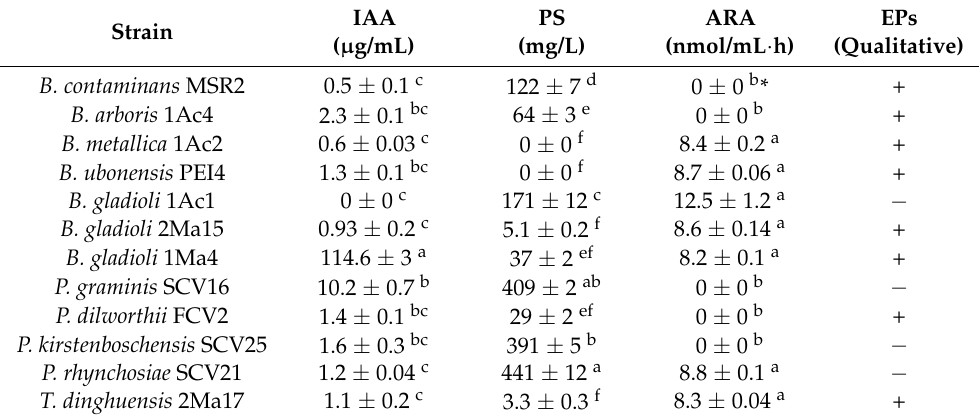
Table 1. Plant growth-promoting activities of rhizosphere Burkholderia sensu lato strains. Strain